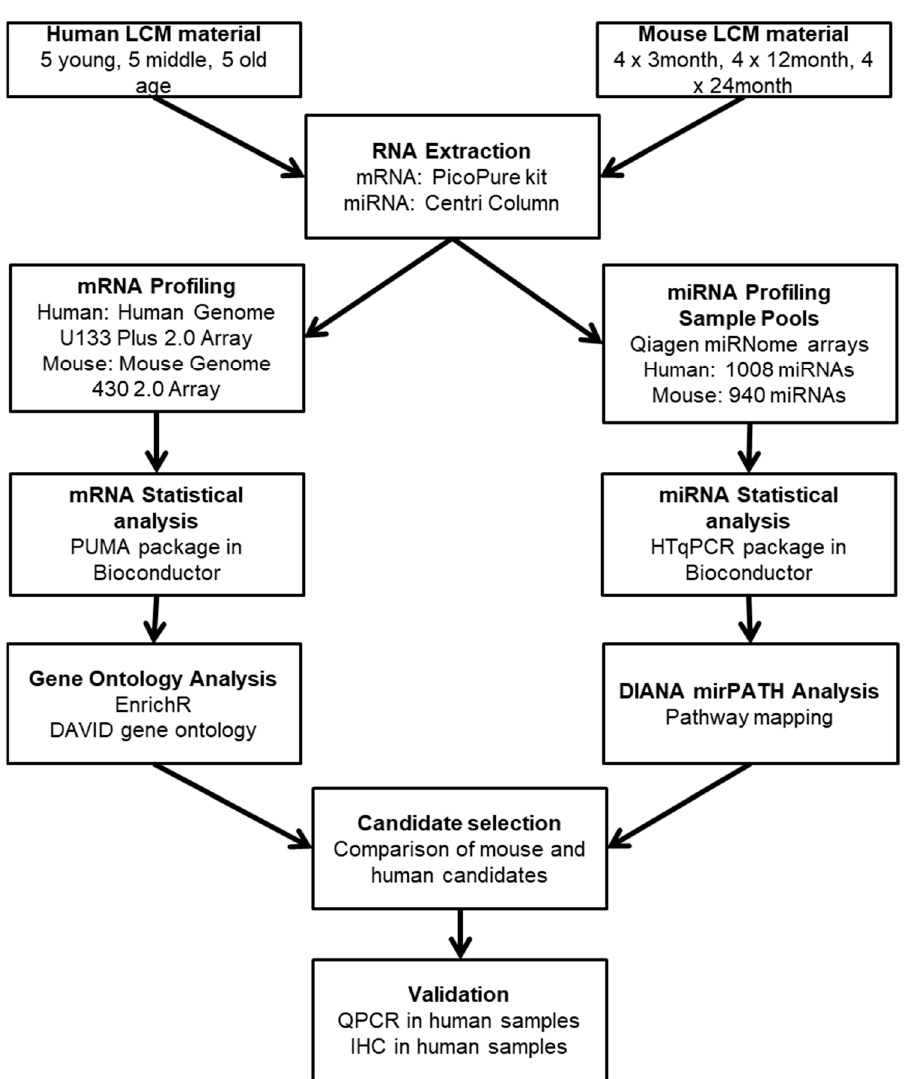
Figure 7. Workflow of the study design, including initial mRNA and miRNA expression